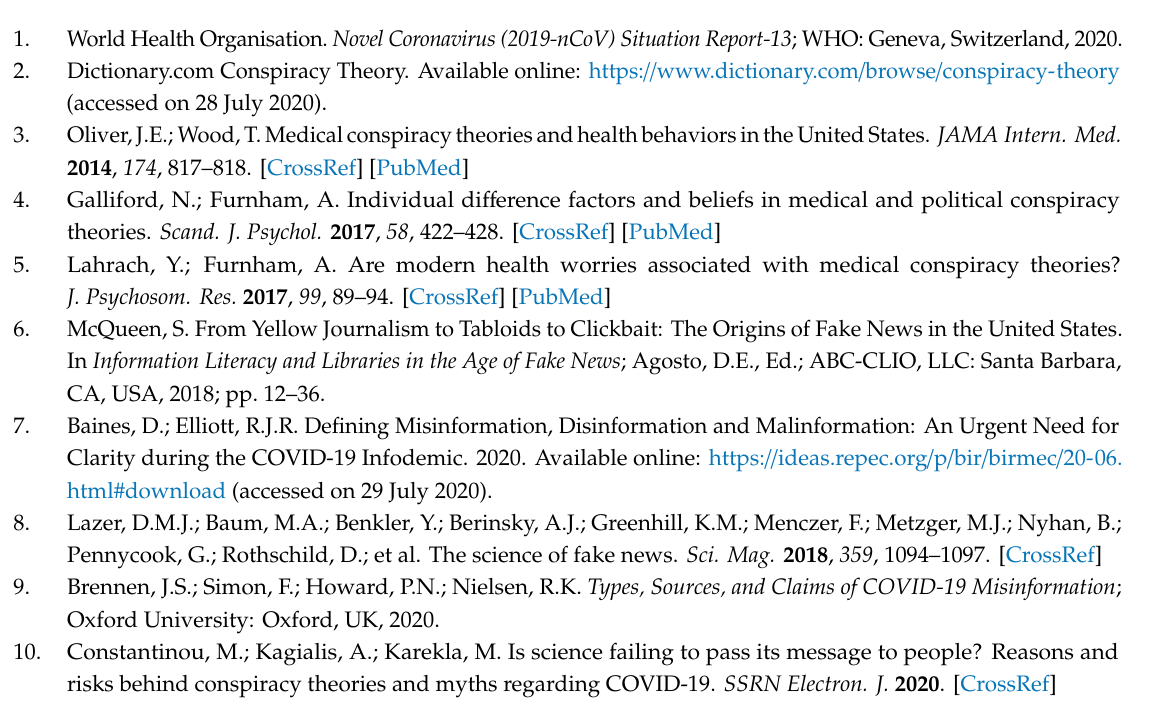
Table S1: The distribution of responses to items asking about conspiracy beliefs related to COVID-19, Table S2: Spearman correlations between independent variables used in regression